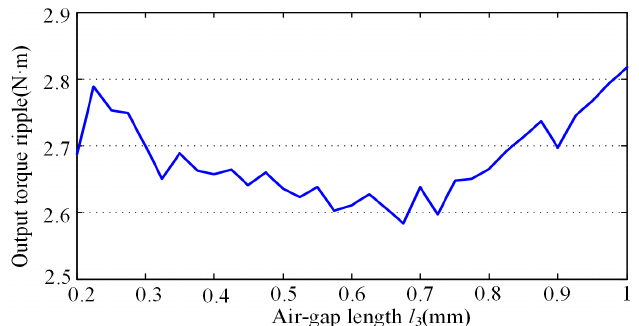
Figure 6. Output torque ripple versus air-gap length l 3 .